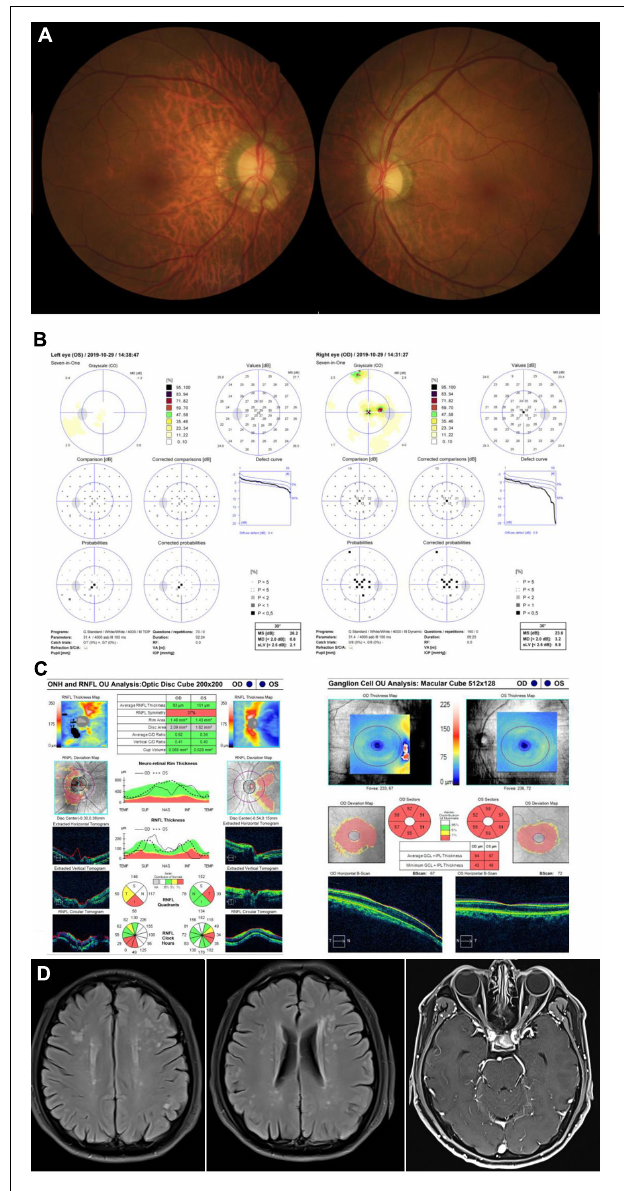
FIGURE 2 | Accessory examinations of case 2. (A) Fundus photos showed temporal pallor of optic disc bilaterally. (B) Octopus visual fields showed central scotomas bilaterally. (C) OCT revealed inferior-temporal RNFL thinning in the right eye and temporal RNFL thinning in the left eye, with significant thinning of the GPICL bilaterally. (D) Brain MRI showed scattered T2 Flair-weighted hyperintense signal and orbital T1-weighted MRI imaging after contrast showed bilateral optic nerve atrophy without